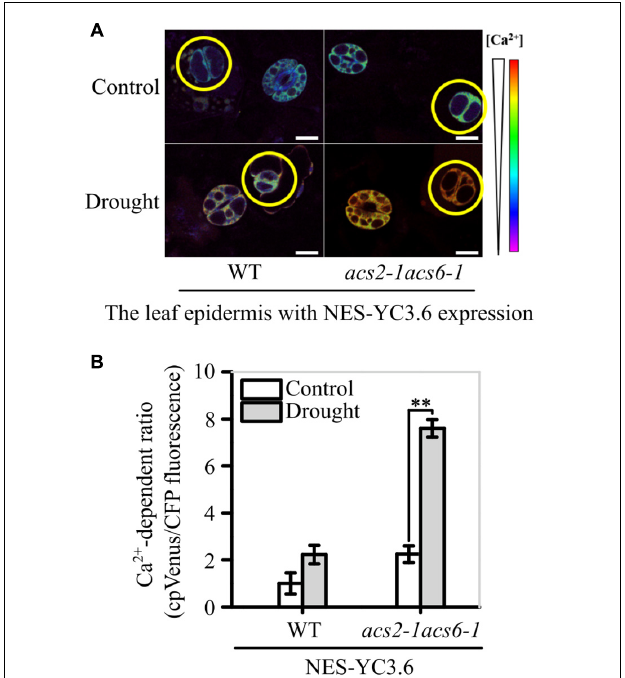
FIGURE 6 | Inhibitory effects of ACS2/6 activation and ACC treatment on SDD1 expression and protein accumulation. (A) RT-qPCR-based relative levels of SDD1 mRNA transcripts in immature leaves of WT, acs2-1 , acs6-1 , acs2-1acs6-1 , ACS2 -OE(#1), ACS2 -OE(#3), ACS6 -OE(#1), and ACS6 -OE(#3) seedlings. The experiment was repeated three times with consistent results. Values are means ± SD (Student’s t -test; ∗ P < 0.05; ∗∗ P < 0.01). (B) Evaluation of SDD1 protein levels by western blotting. The fusion protein GFP-SDD1 was collected from immature leaves of pSDD1 :: SDD1 - GFP -expressing WT or acs2-1acs6-1 lines with or without drought treatment. Levels of GFP-SDD1 fusion protein were determined using GFP antibody. GAPDH protein was used as a loading control. The experiment was repeated three times with consistent results.